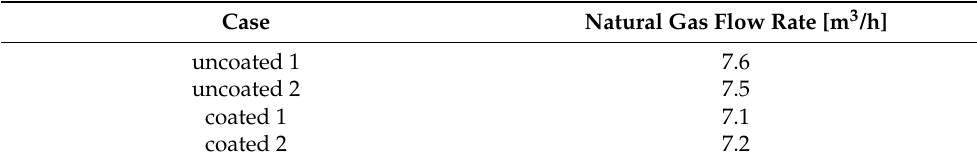
Table 3. Natural gas flow rate to the pilot unit at steady state for the different